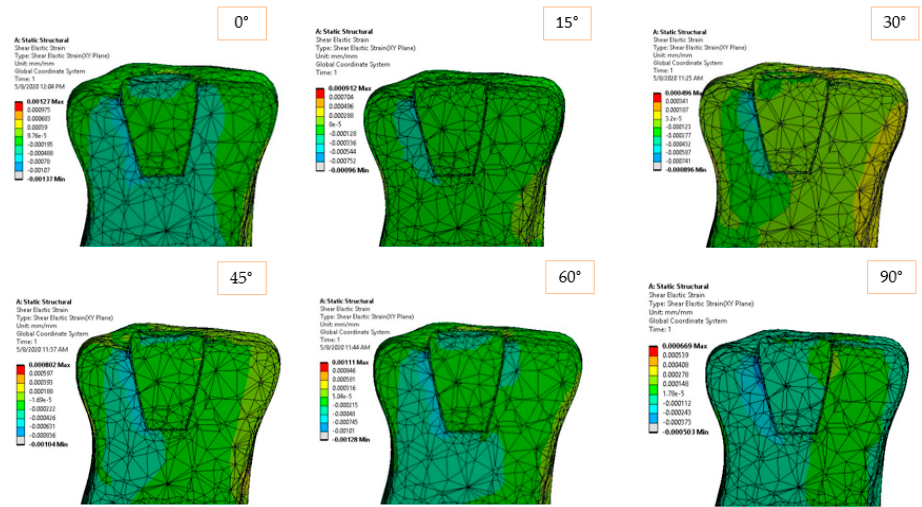
Figure 9. Shear strain in XY plane for 170 N load and 0°–90° loading direction.